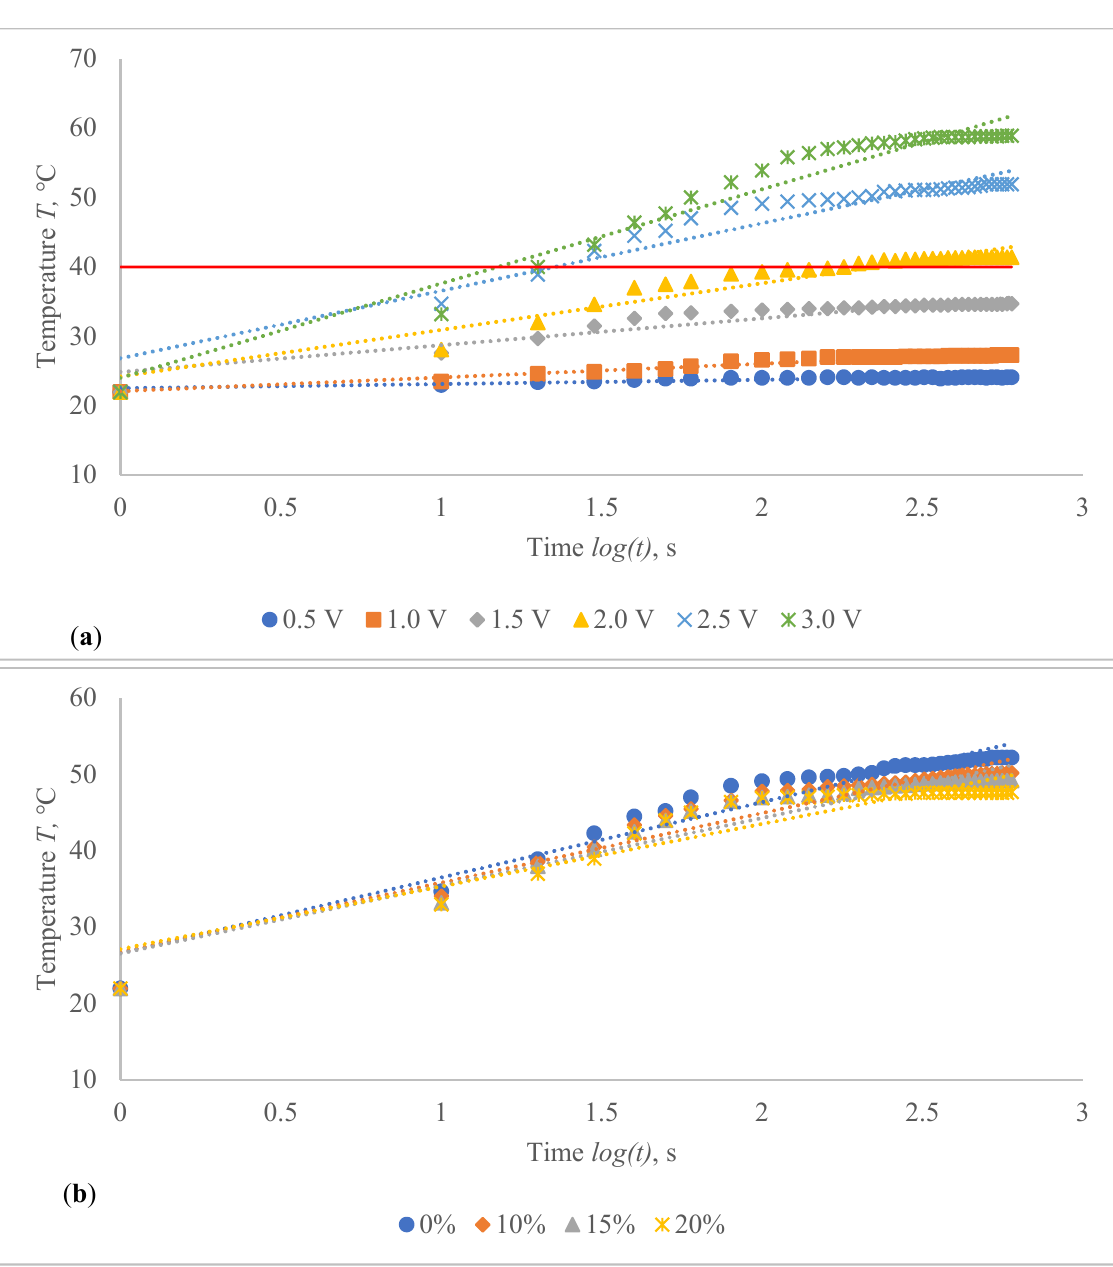
Figure 10. Temperature changes of CF_LY1 structured electro-conductive composite fabric during the 600 s period: ( a ) at non-stretched state by applying different voltage; and ( b ) at the different stretch levels by applying 2.5 V. Red line indicates the target